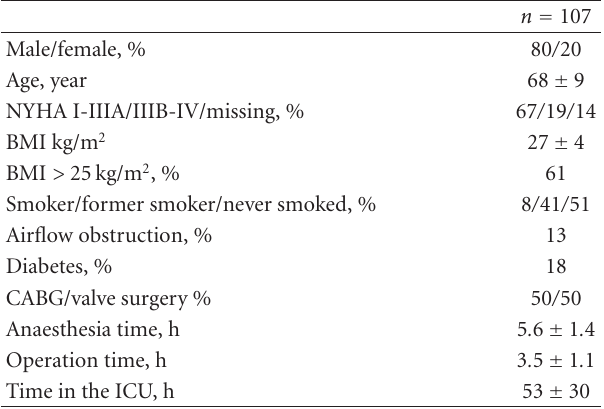
Table 1: Descriptive data of the study group ( n = 107).